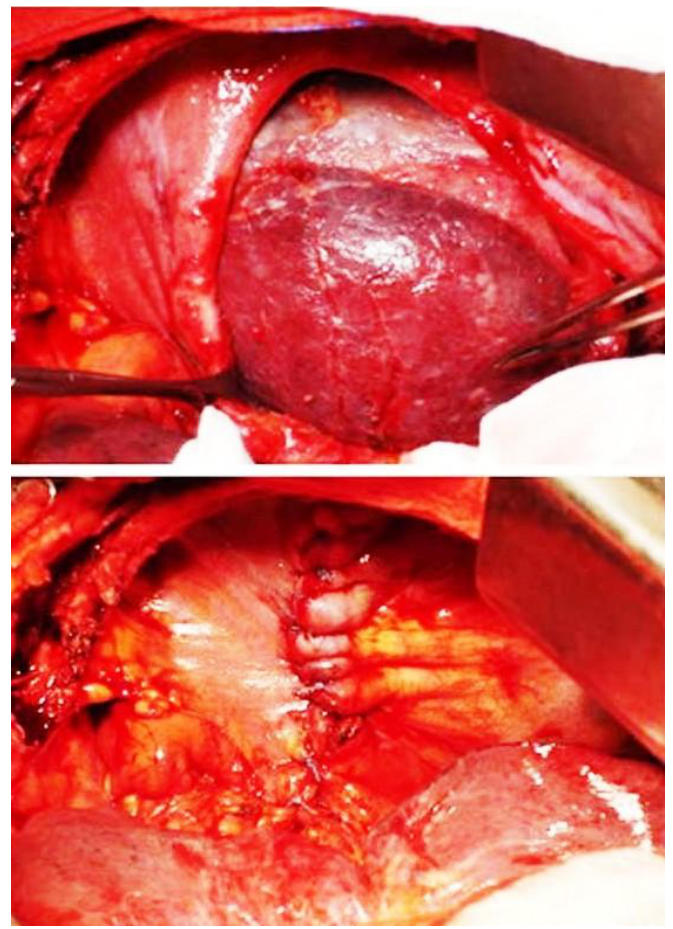
FIGURE 3. The liver reduction in the abdomen and diaphragmatic suture with separate